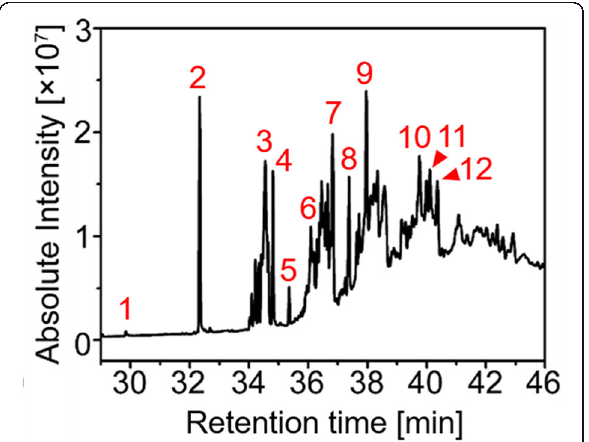
Fig. 3 Gas chromatograms of CFAME. Overlapped chromatographic peaks and baseline drift were observed, which could be attributed to mismatch between multipolarity of the chlorinated components and unipolarity of the chromatographic